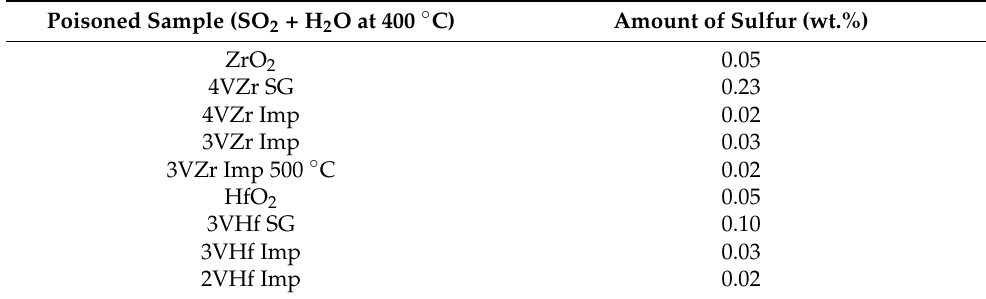
Table 2. Sulfur amount in poisoned